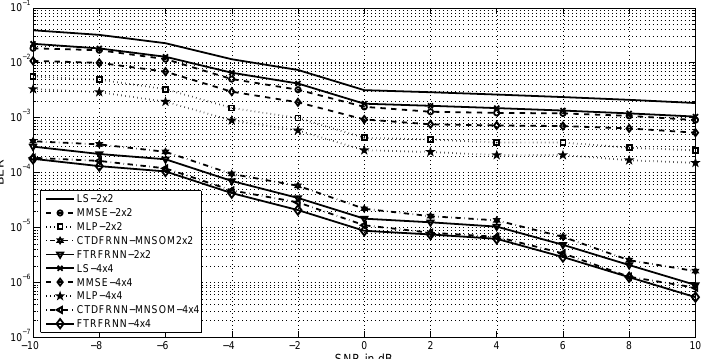
Figure 7. Comparative BER plot generated by FTDFRNN in comparison to (i) sta- tistical methods (LS, MMSE), (ii) ANN based standard methods (MLP [15]), (iii) RNN based approaches (CTDFRNN-MNSOM [16]) and (iv) the proposed architec- ture (FTDFRNN) in 2 (cid:2) 2 and 4 (cid:2) 4 set-ups in severely faded channels.